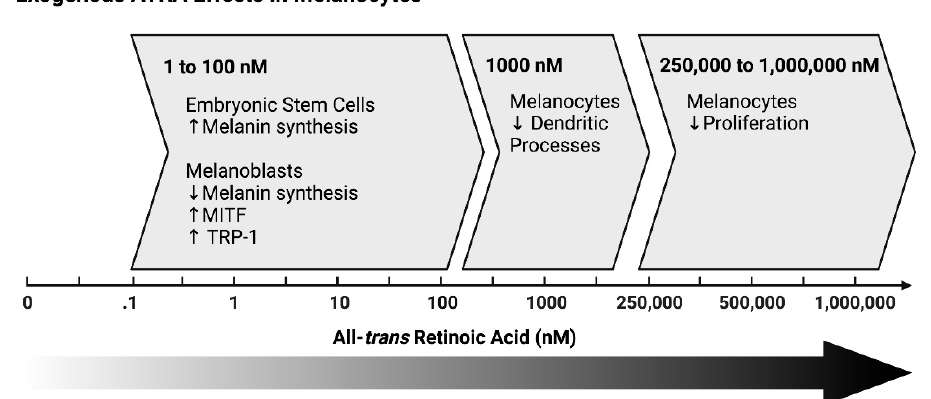
Figure 2. Dose-dependent effects of exogenous RA on melanocytes: 01–100 nM: In embryonic stem cells, ATRA promoted melanin synthesis into melanoblasts. In melanoblasts, ATRA inhibited melanin synthesis [74]. In melanoblasts, ATRA increased both melanocyte-inducing transcription factor and tyrosine-related protein 1, but inhibited these genes in melanocytes [75]. After 12 h of 1000 nM ATRA, melanocytes started to lose dendritic processes [72]. Proliferation was reduced at 250,000 nm ATRA and stopped at 1,000,000 nm. Melanocyte dendrites were lost [73]. Created in BioRen- der,com.